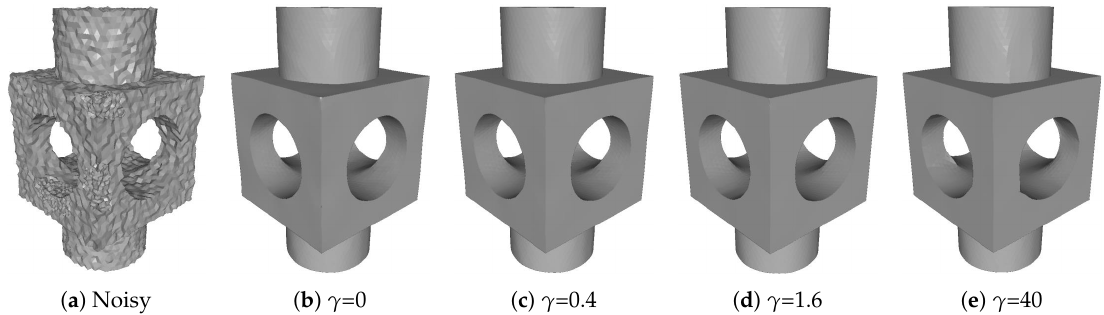
Figure 3. Denoising results for different γ with fixed other parameters ( α , β , and δ ). From left to right: input noisy mesh (corrupted by Gaussian noise with standard deviation σ = 0.2 mean edge length) and results with different γ .